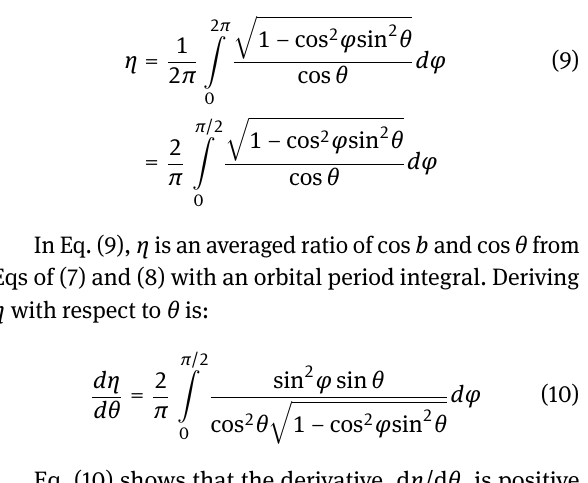
plane consisting of OS and OH , and OY r given by the right hand rule is OZ r × OX r . Assuming that the satellite moves from the initial po- sition A to the point B , the angle between OA and OB is defined as the orbital phase, φ . When the satellite arrives at the point B , OB is the yaw axis. Rotating OB makes ON that is the panel normal, OS and OB on the same plane with a yaw angle, c . The angle a is between OS and OB . The angle b is the panel incidence between OS and ON , θ is the orbit incidence, and β is the angle between the plane ONSB and the plane OHSA .